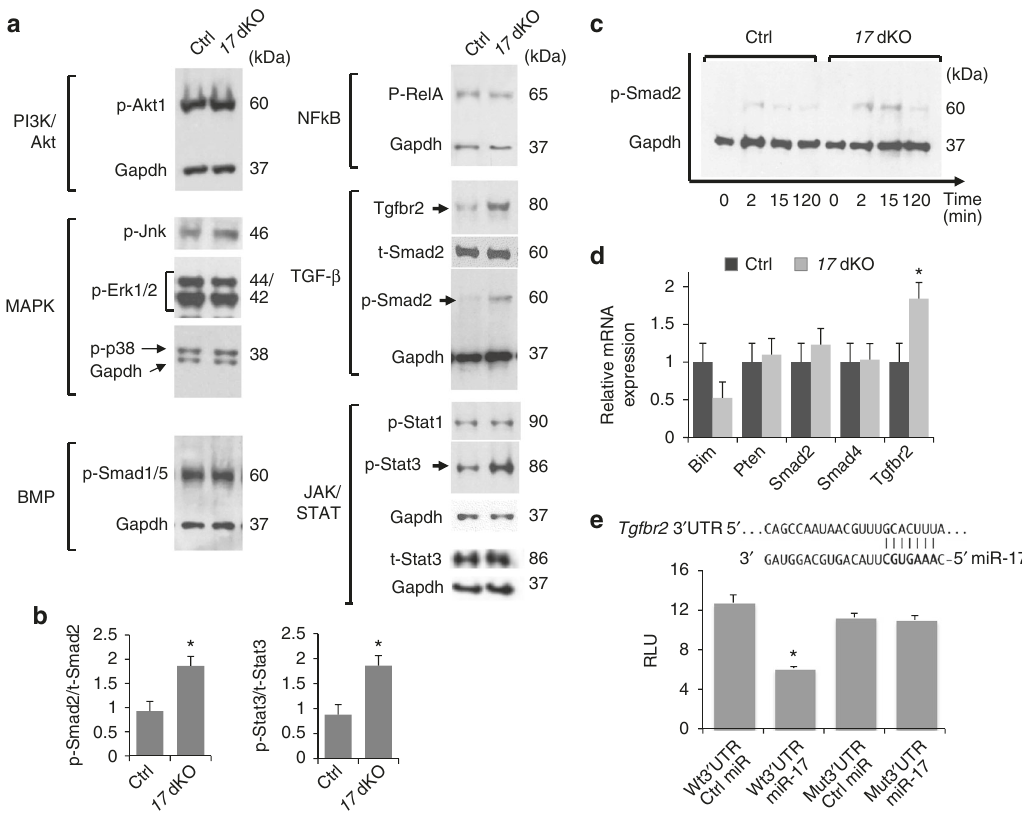
Fig. 3 TGF- β and STAT3 upregulation in miR-17-92 miRNA-de fi cient cells. a Immunoblot analysis on indicated proteins using protein lysates from cells cultured in DMEM containing 10% FBS. Levels of p-Smad2, Tgfbr2, and p-Stat3 (arrows) are increased in Mir17-92:Mir106b-25 -de fi cient limb bud cells ( 17 dKO). b Quanti fi cation of the p-Smad2 to total Smad2 (t-Smad2) and p-Stat3 to total Stat3 (t-Stat3) protein ratios based on western blot data ( n = 3, * p < 0.05). c Increased TGF- β signaling in 17 dKO cells upon stimulation. Serum-starved cells were treated with 50 ng/ml TGF- β 1. Smad2 phosphorylation was analyzed at the indicated time points. d Relative mRNA expression of known targets of miR-17-92 miRNAs in 17 dKO limb bud cells ( n = 3, * p < 0.05). e Luciferase reporter assay for miR-17 regulation on Tgfbr2 binding site. Primary limb bud cells were co-transfected with control miRNA mimic (Ctrl miR) or mmu-miR-17-5p (miR-17) and a luciferase reporter construct carrying a wildtype (Wt 3 ′ UTR) or mutated 3 ′ UTR (Mut 3 ′ UTR) sequence of mouse Tgfbr2 . The predicted binding sequence of Tgfbr2 3 ′ UTR and relative luciferase units (RLU) are shown ( n = 6, * p <